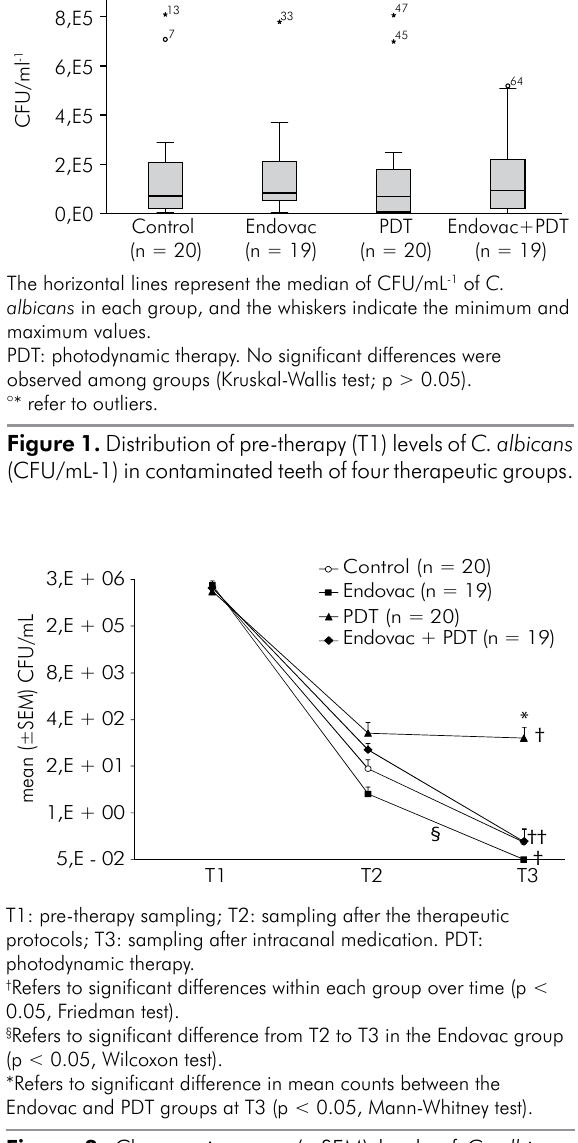
Figure 2. Changes in mean (±SEM) levels of C. albicans (CFU/mL -1 ) over time in the four therapeutic